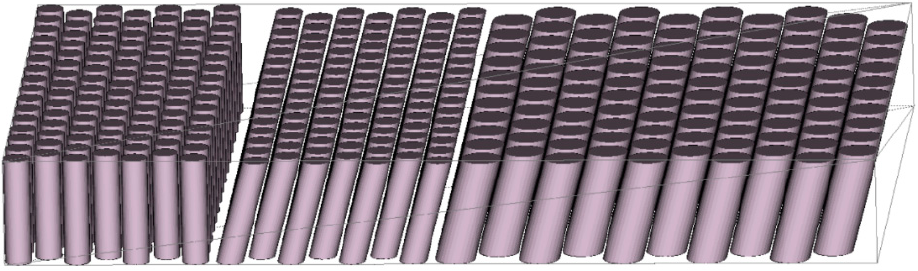
Figure 15. Arrangement of the CGx on BP_1_1-1.